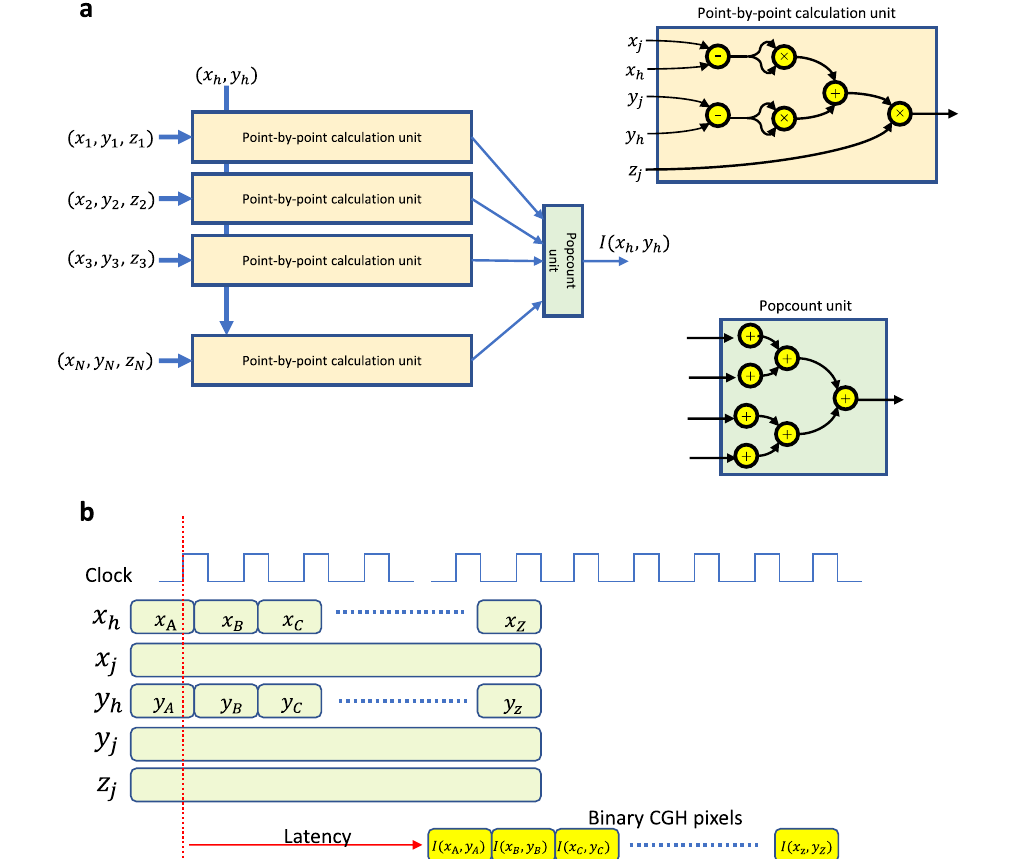
Fig.9|SerialcomputationofCGH.a AbinaryCGHprocessorforopto-magneticrecordingwith popcount unitfortheaccumulationoffourbinarybits. b Timingchartof the